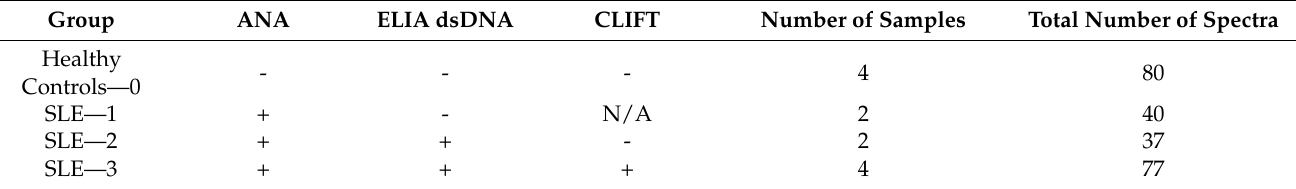
Table 1. Categories of SLE patients determined by autoantibody positivity combinations.